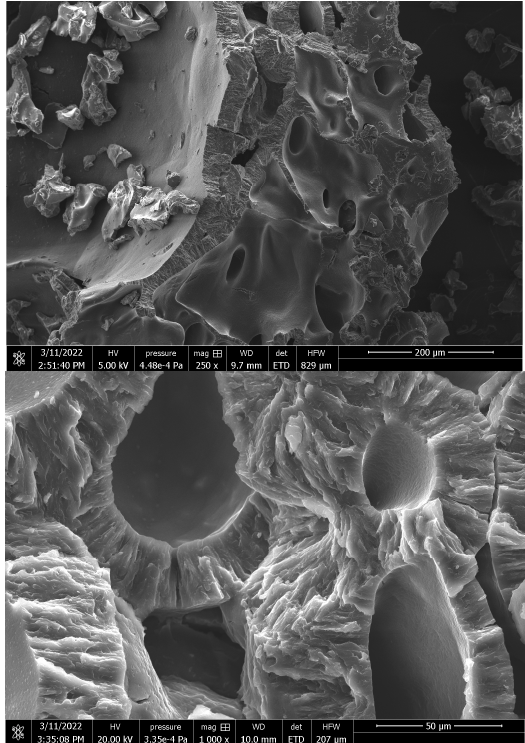
Pharmaceutics 2022 , 14 , x FOR PEER REVIEW Figure 3. Representative SEM images of PL-HA-GSNO-SiO 2 @CisPt lyophilized hydrogel.